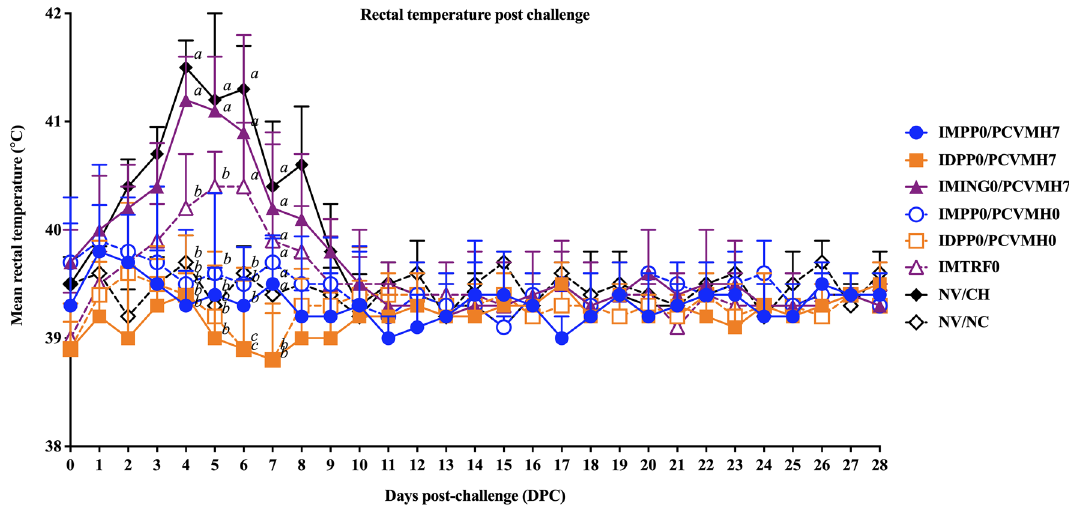
Figure 1. Mean values of rectal temperature post-challenge. Values expressed as mean ± SEM. The results were compared using two-way ANOVA for multiple comparisons. Different lowercase letters (a–c) indicate significant differences between treatment groups ( p < 0.05) for each